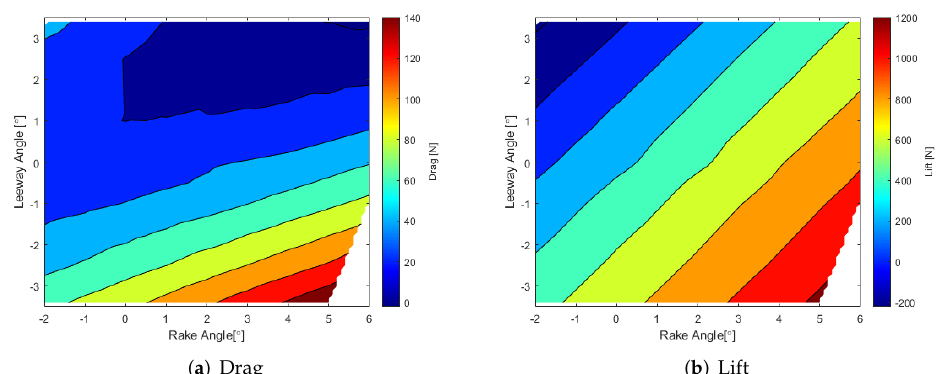
Figure 26. Averaged z-displacement for the investigated ranges of leeway and rake angles at flow speeds of 7 and 9 m/s.